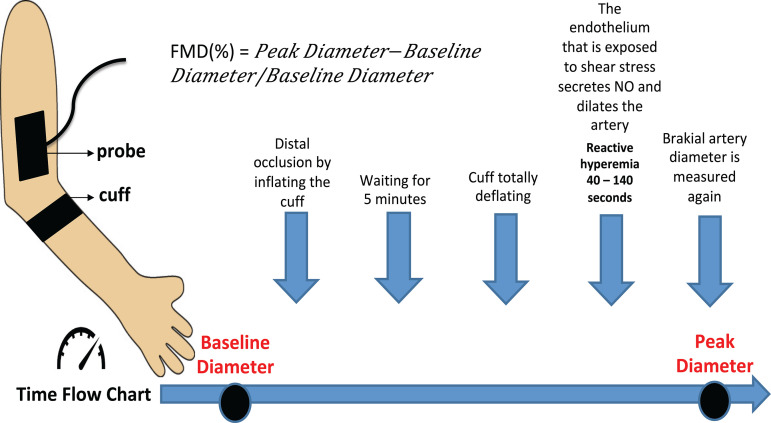
Flow-mediated dilation (FMD). NO=nitric oxide